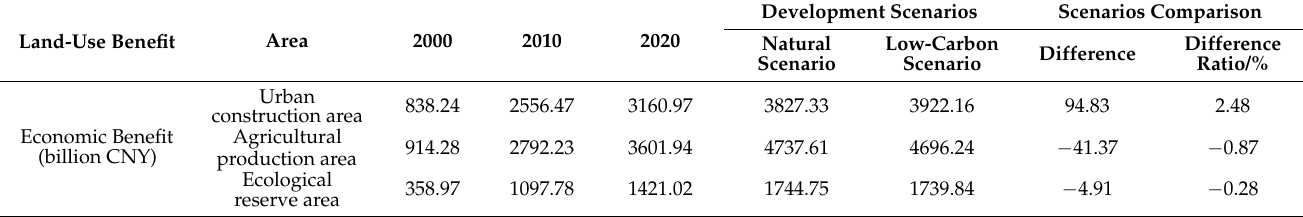
Table 9. Comparison of ecological benefits in different development